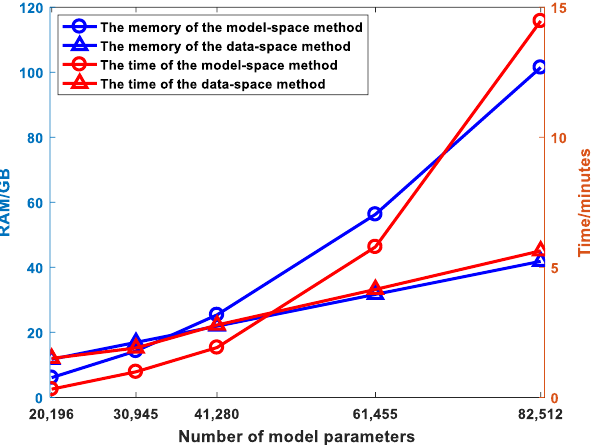
Figure 2. The performance of the model-space and the data-space inversion algorithms.